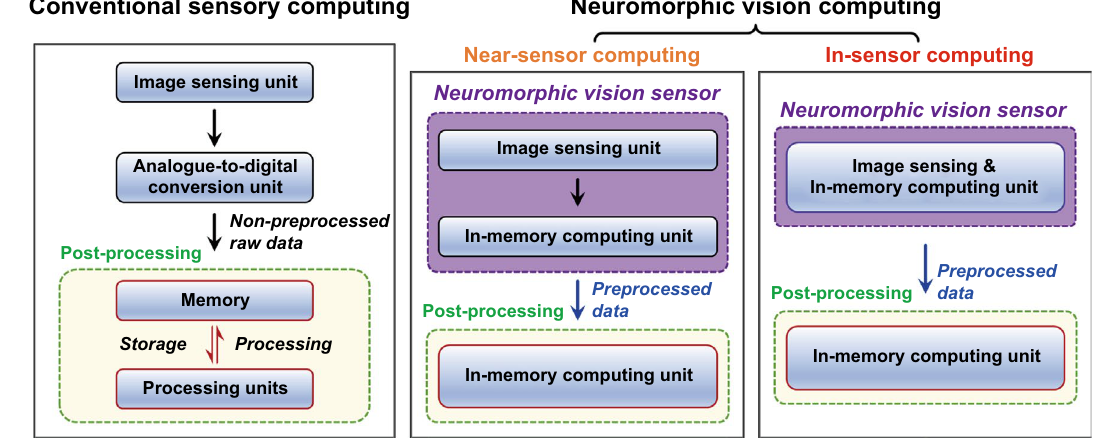
Fig. 1 Image processing flow of conventional sensory computing and neuromorphic vision computing